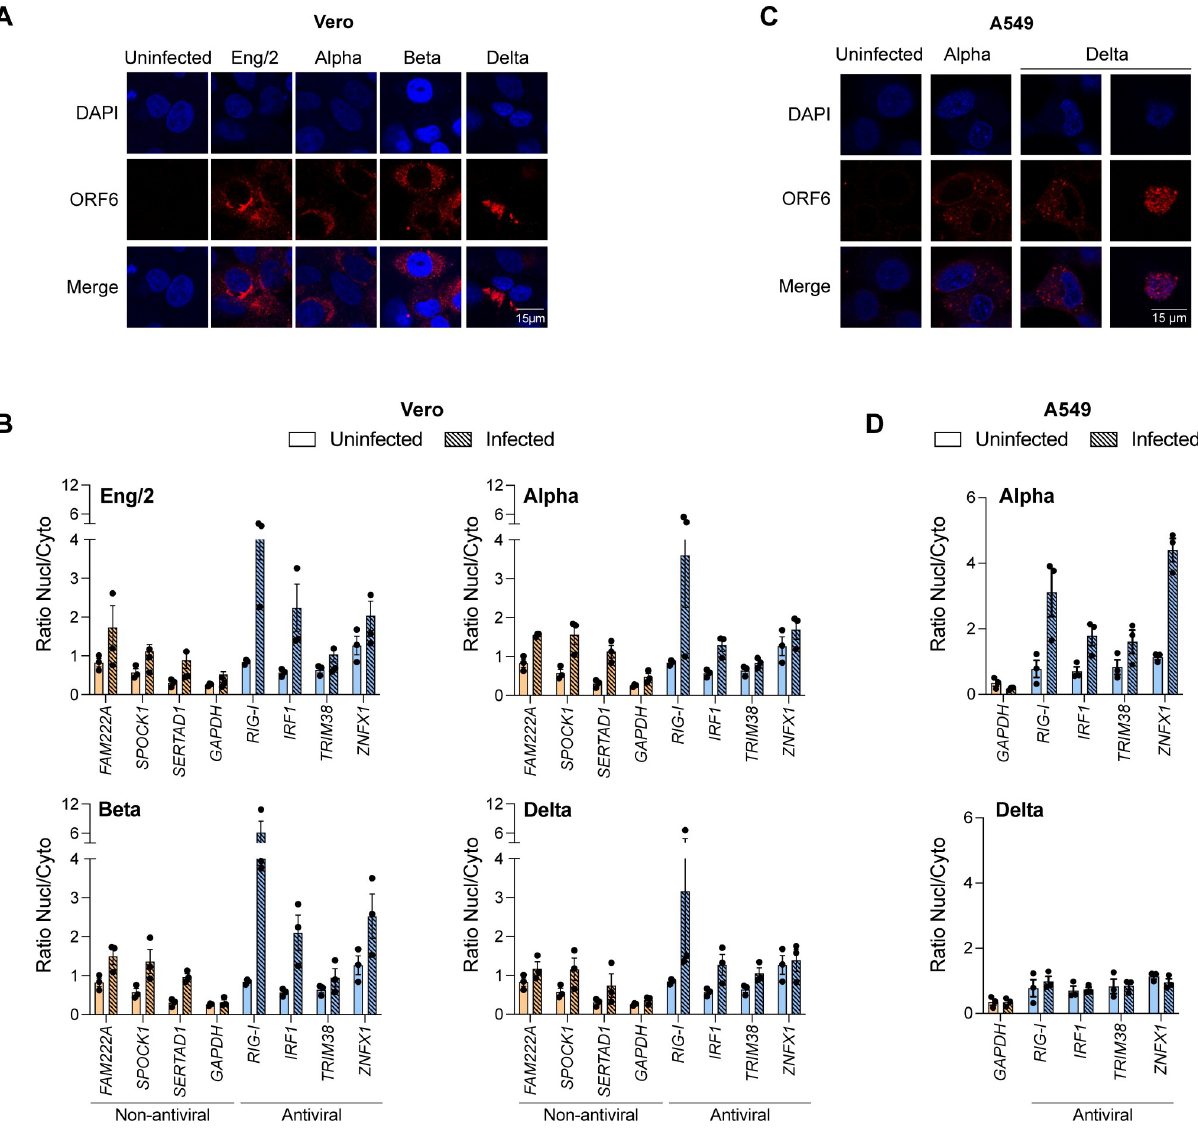
Fig 5. SARS-CoV-2 inhibits the export of cellular mRNA. (A, B) Vero cells were inoculated with four SARS-CoV-2 variants (Eng/2, Alpha, Beta, Delta) at a MOI � 1 or left uninfected for 24h. (A) Cells were fixed and analysed by immunofluorescence with anti-ORF6 and DAPI. (B) Cells were fractionated, RNA was extracted, and cDNA was generated. mRNA levels of four non-antiviral (orange) and four antiviral (blue) proteins in both Nucl and Cyto fractions were measured by qPCR. The ratio of Nucl to Cyto mRNA was calculated and plotted. (C, D) A549-ACE2/TMPRSS2 cells were inoculated with two SARS-CoV-2 variants (Alpha, Delta) at a MOI � 1 or left uninfected for 24h. (C) Cells were fixed and analysed by immunofluorescence with anti-ORF6 and DAPI. (D) Cells were fractionated, RNA was extracted, and cDNA was generated. mRNA levels of GAPDH (orange) and four antiviral (blue) proteins in both Nucl and Cyto fractions were measured by qPCR. The ratio of Nucl to Cyto mRNA was calculated and plotted. Points indicate individual biological repeats and error bars show the mean ± SEM. (Fig 5C). As we observed before, SARS-CoV-2(delta) severely affect cell viability and in a sub- set of cells the pattern of ORF6 expression was altered, becoming predominantly nuclear. As